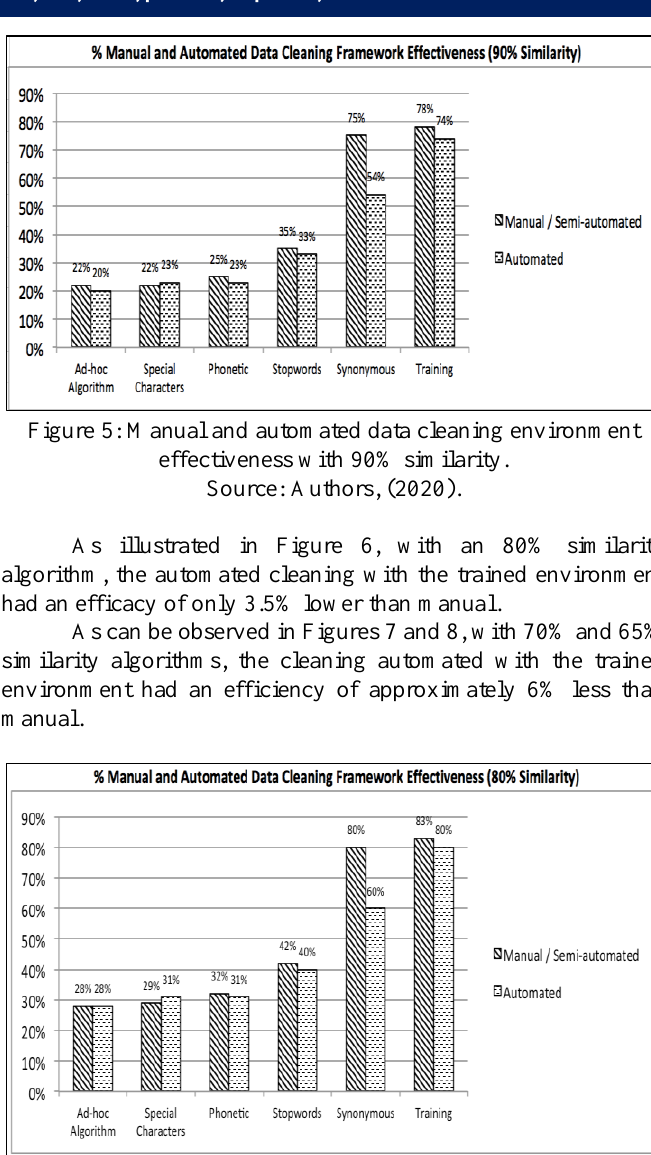
Figure 6: Manual and automated data cleaning environment effectiveness with 80% similarity.